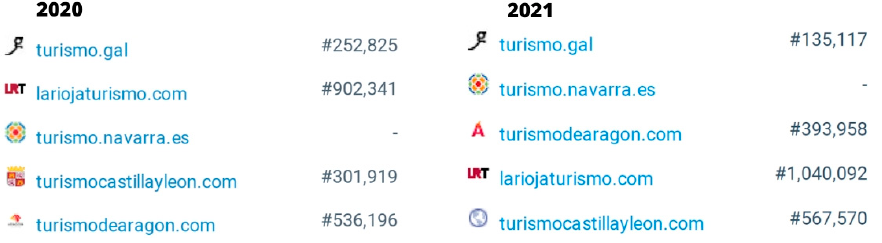
Figure 2. World ranking of official Spanish websites, 2020–2021.